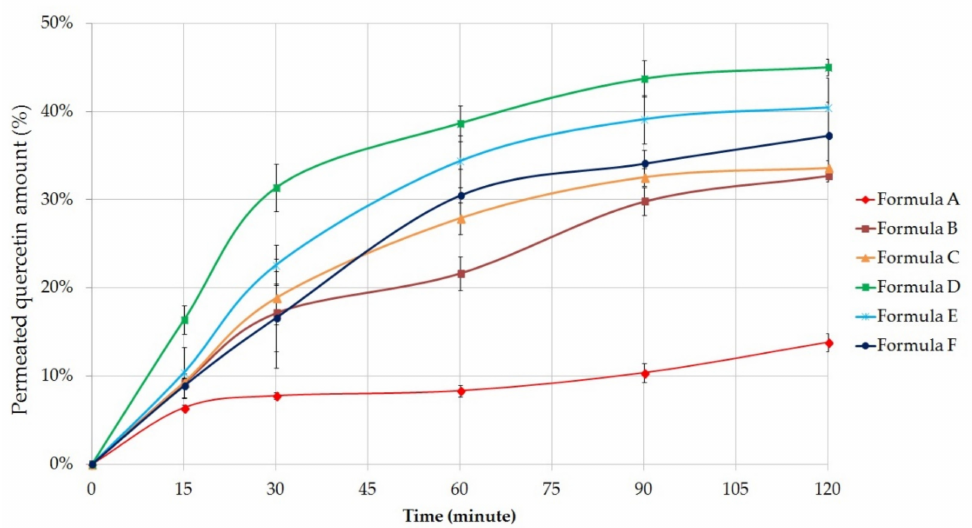
Figure 5. In vitro permeation profile of quercetin across isopropyl myristate (IPM) im- pregnated cellulose acetate membrane from Formula A–F. Bars represent mean ± S.D. ( n =